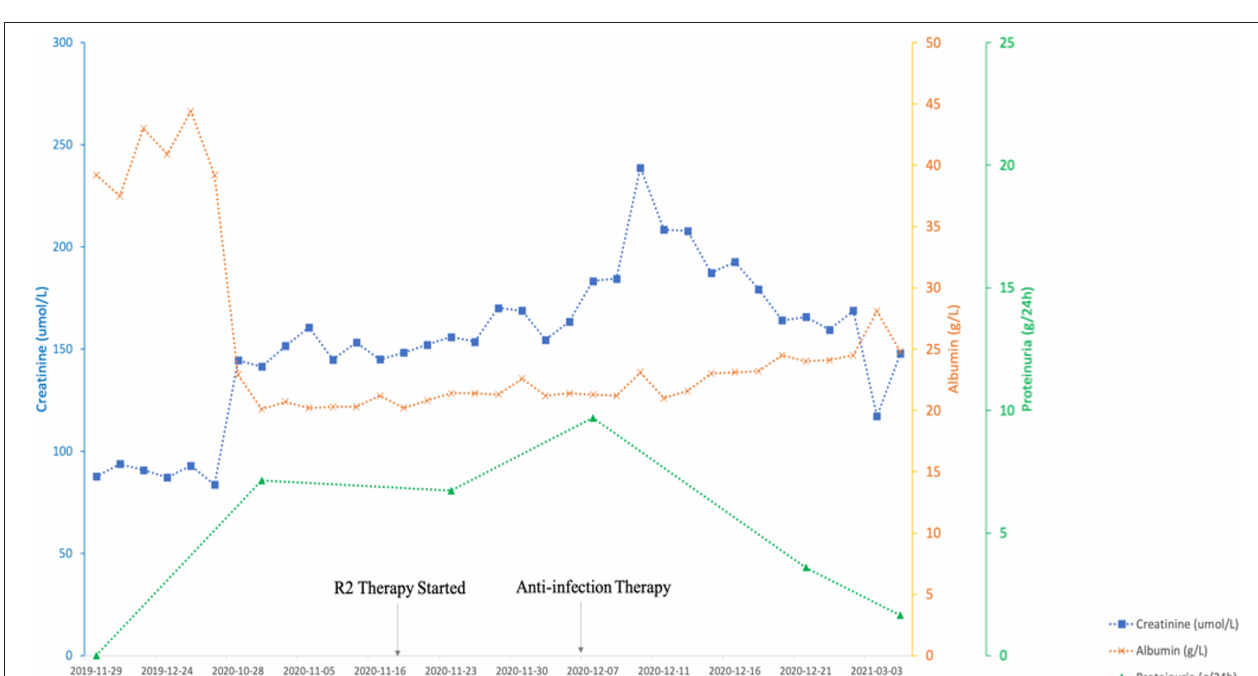
FIGURE 2 | The clinical course of the present case. R2 Therapy indicates Rituximab and lenalidomide.